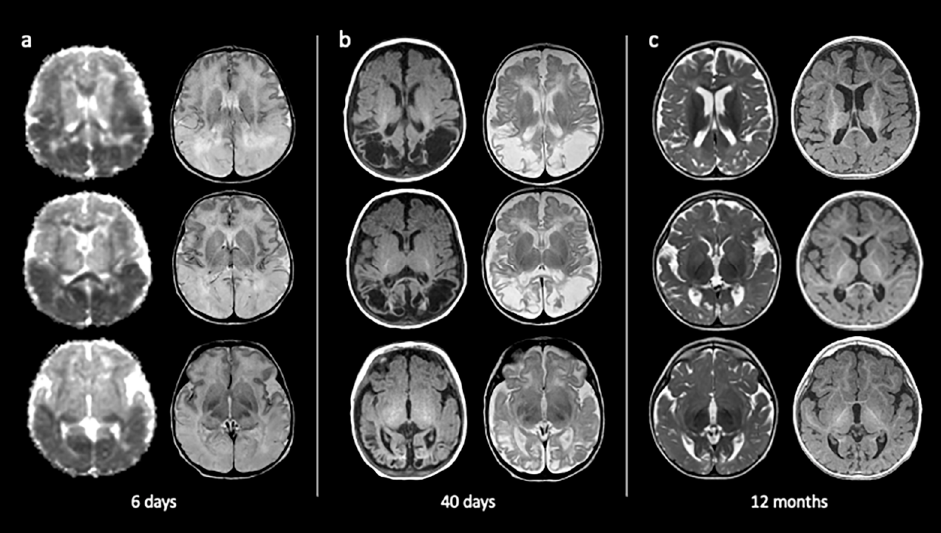
Figure 2. Evolving brain injury in brain MRI from perinatal hypoglycaemia. Symptomatic hypoglycaemia was detected on day 4, postnatally. A posterior brain lesion pattern is reported here, with predominant parietal and occipital lobe involvement. From the left to the right side of the images, brain MR axial images of the same patient are shown at 6, 40 days, and 12 months of age. In detail, ( a ) DWI (left) and T2W (right) images showing abnormal signal intensities and oedema in the parietal and occipital regions; ( b ) T1W (left) and T2W (right) images showing the evolution of hypoglycaemia-related abnormalities to brain poromalacia in the same parietal and occipital regions; ( c ) T2W (left) and T1W (right) images depict chronic brain abnormalities with parietal and occipital white and grey ma tt er volume reduction and local signal tissue abnormalities, in particular involv- ing occipital cortical areas.